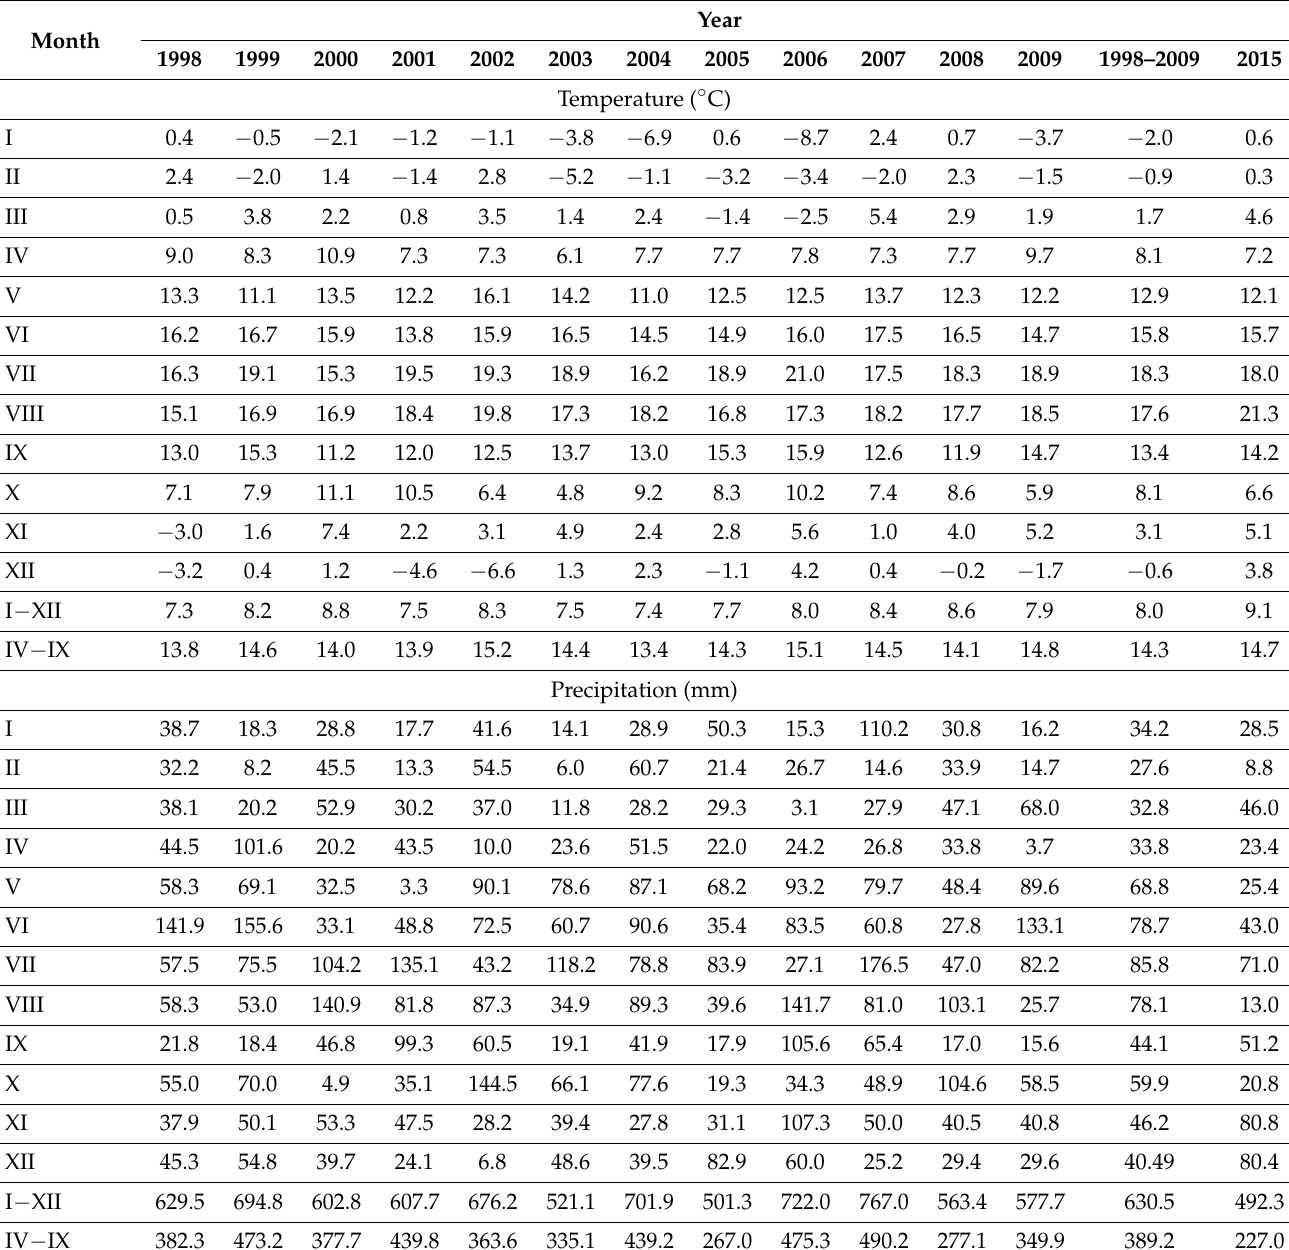
Table 2. Mean monthly temperature and total precipitation in the study